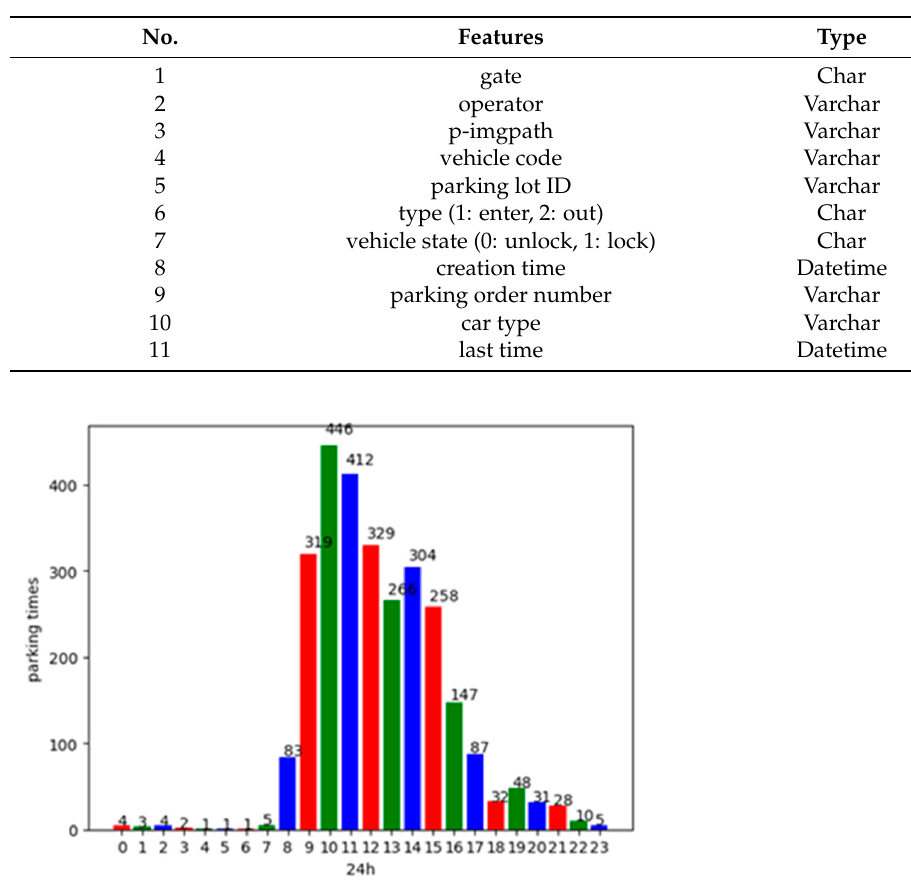
Table 1. Features of parked vehicles in the data set.